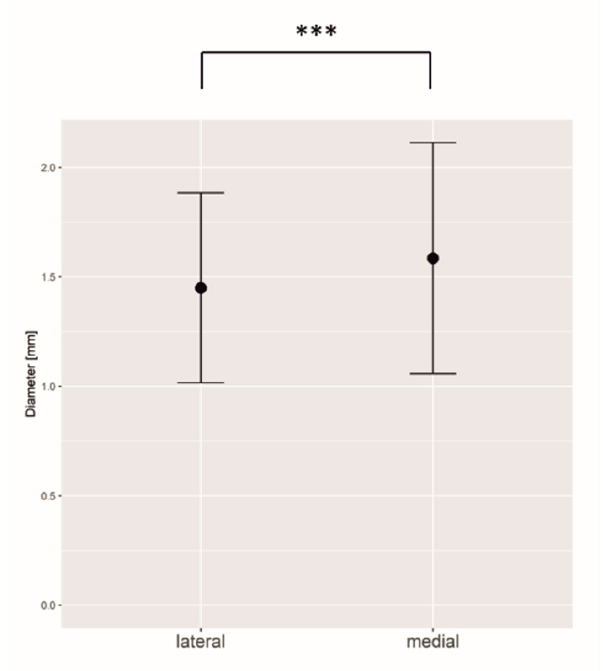
Figure 2. Medial row perforators have a statistically significantly larger diameter than lateral row perforators. *** = p ≤ 0.001.